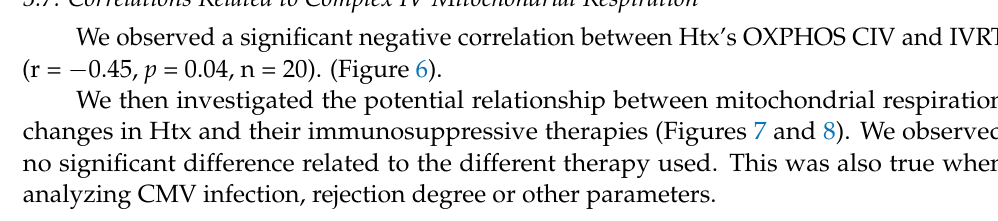
Figure 5. Correlation between OXPHOS CII and number of leukocytes ( a ), number of lym ‐ phocytes ( b ) and Posterior wall (PW) peak early diastolic myocardial velocity (cm/s), ( c ).